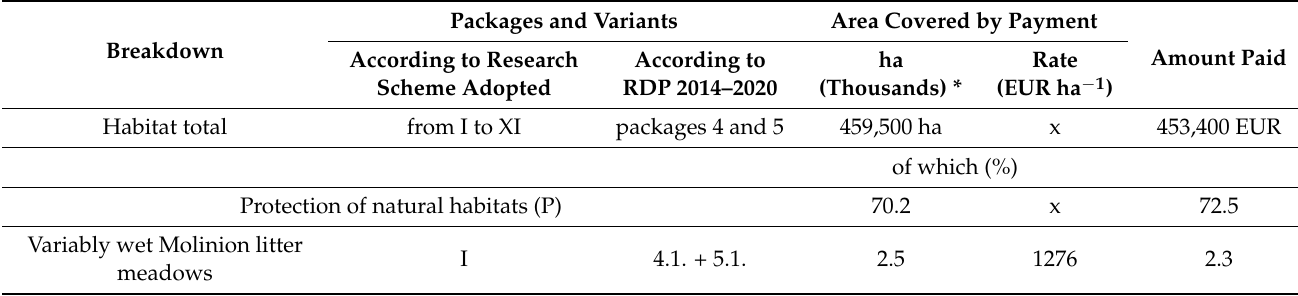
Table 1. Support for the protection of nature value habitats under the RDP 2014–2020 agri-environment-climate measure—subsidised area and payment